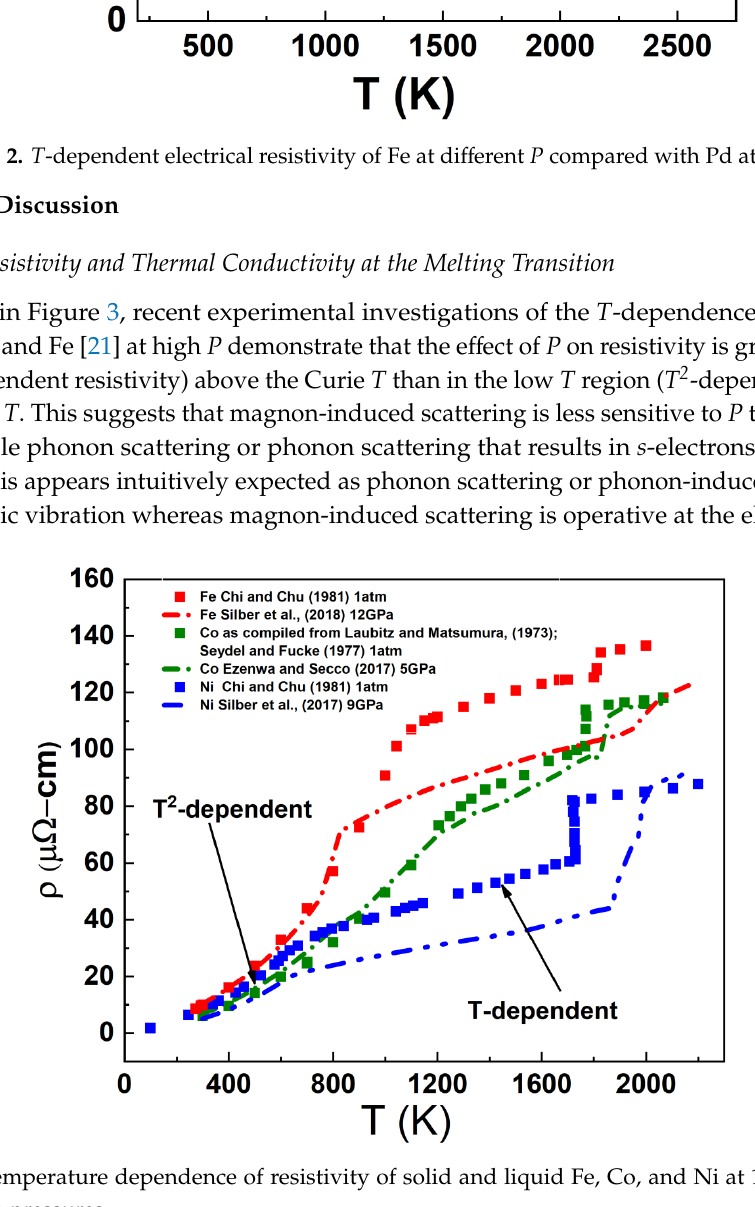
Figure 2. T -dependent electrical resistivity of Fe at different P compared with Pd at 1 atm.